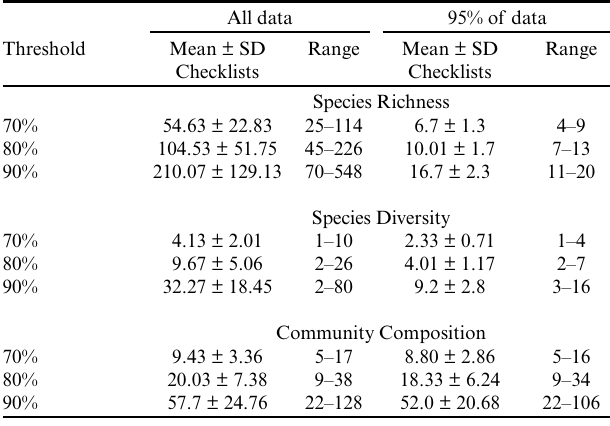
Table 1 . The minimum number of checklists (2010–2016), necessary to meet 70%, 80%, and 90% thresholds for 30 greenspaces throughout Canada and the United States (Table A1.1) for species richness, species diversity, and community composition (Bray- Curtis similarity). Separate analyses are provided for the full dataset, and for those species recorded on > 5% of all checklists at the